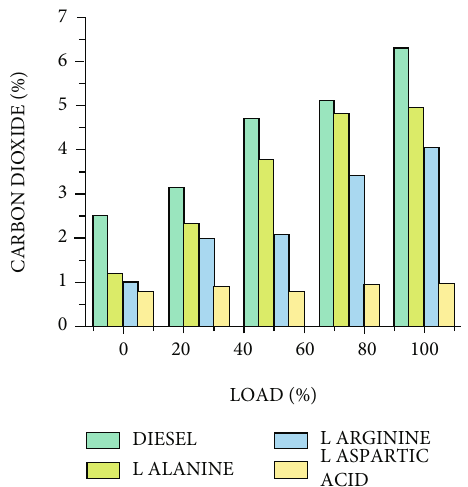
Figure 11: Variation of carbon dioxide with respect to engine load.